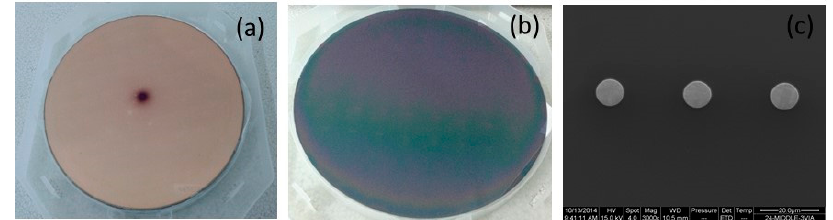
Figure 3. ( a ) Unpolished wafer surface; ( b ) polished wafer surface; ( c ) through-silicon-via (TSV) Cu stud after CMP process.